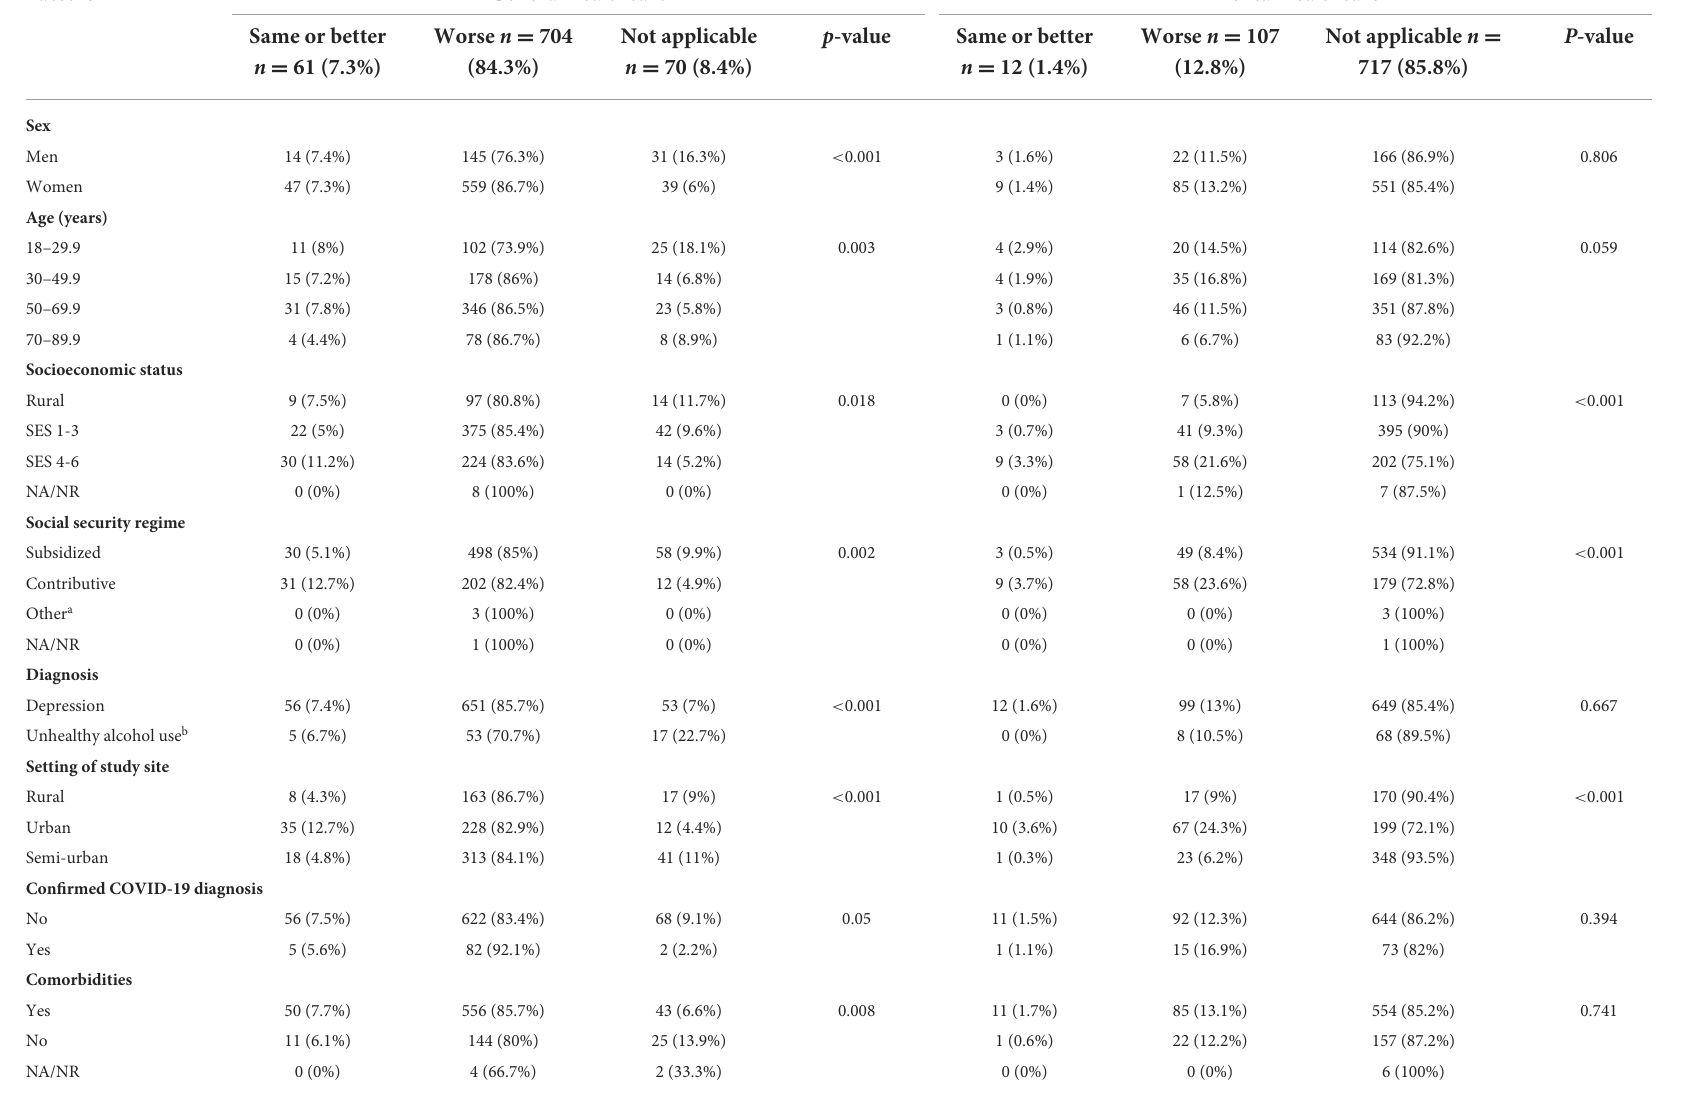
TABLE 2 Distribution of sociodemographic and clinical factors related to perceived ease of access to general or mental healthcare. Factors General healthcare